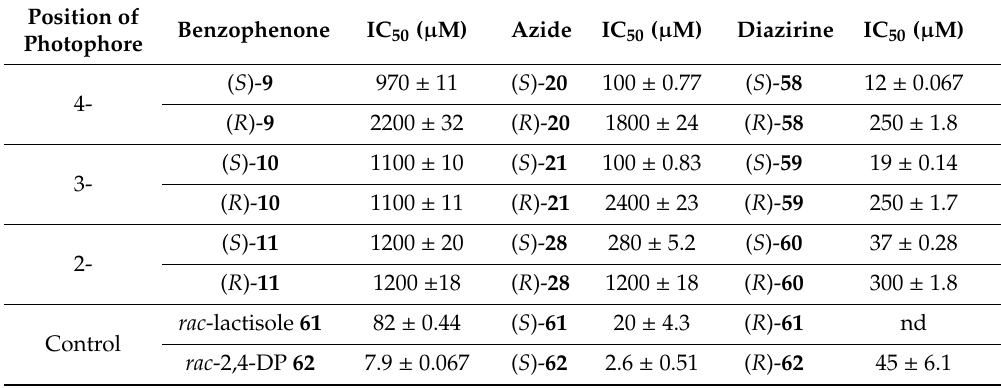
Table1. Inhibitoryactivitiesofphotophorecontaininglactisolederivatives. IC 50 :